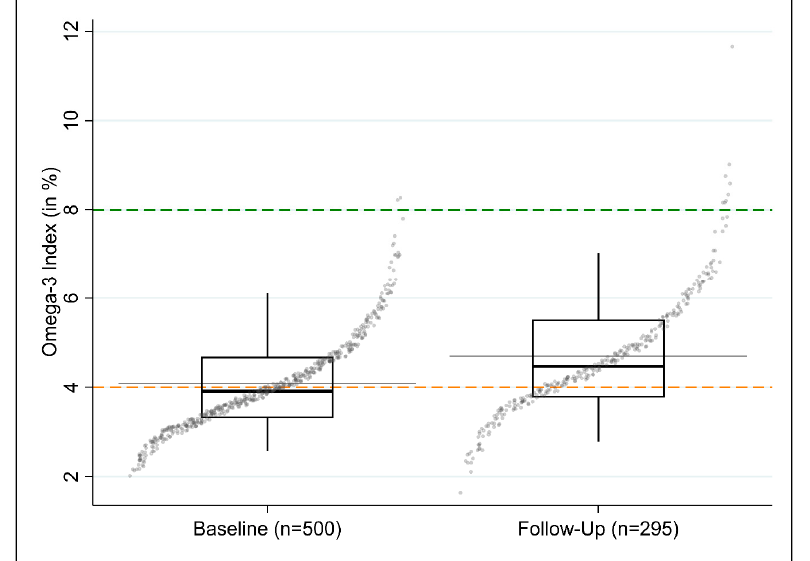
Figure 4. Box quantile plot for the distribution of the O3I at baseline ( n = 500) and follow-up ( n = 295) of the study. The gray horizontal line shows the arithmetic mean, the bold, black horizontal line inside the box shows the median. The bottom and top of the box are the bottom and top quartiles of the distribution. The length of the black, vertical “whiskers” corresponds to the 5th and 95th percentile of the variable. The quantile plots the ordered values of the respective variables (ordinate) against the cumulative probability (abscissa). For illustrative purposes, horizonal dispersion (“jitter”) was added to the individual